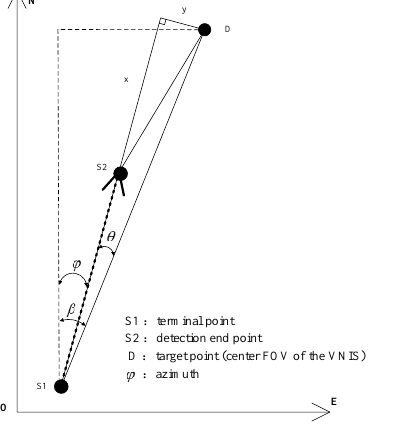
Figure 3. Location diagram of the terminal point, azimuth and detection target.